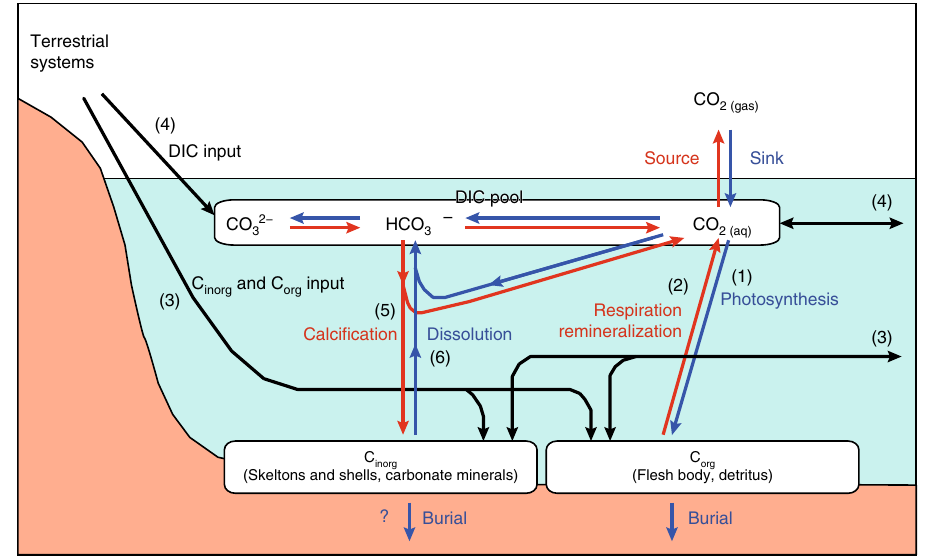
Fig. 1 Conceptual diagram showing the biogeochemistry of carbon associated with air-water CO 2 exchanges. Blue lines indicate the processes that enhance the uptake of atmospheric CO 2 , and red lines indicate those that enhance the emission of CO 2 into the atmosphere. The CO 2 concentration in surface water is primarily responsible for determining the direction of the fl ux. The concentration of surface water CO 2 is determined by carbonate equilibrium in dissolved inorganic carbon (DIC) and affected by net ecosystem production (the balance of photosynthesis, respiration, and remineralization), which directly regulate DIC (1 and 2), allochthonous particulate and dissolved organic carbon (C org ), particulate inorganic carbon (C inorg ), and DIC inputs from terrestrial systems and coastal oceans (3 and 4), net ecosystem C inorg production (the balance of calci fi cation and dissolution), directly regulating both DIC and total alkalinity (TA) (5, 6), and temperature (solubility of CO 2 ). Calci fi cation produces CO 2 with a ratio (released CO 2 /precipitated C inorg ) of approximately 0.6 in normal seawater